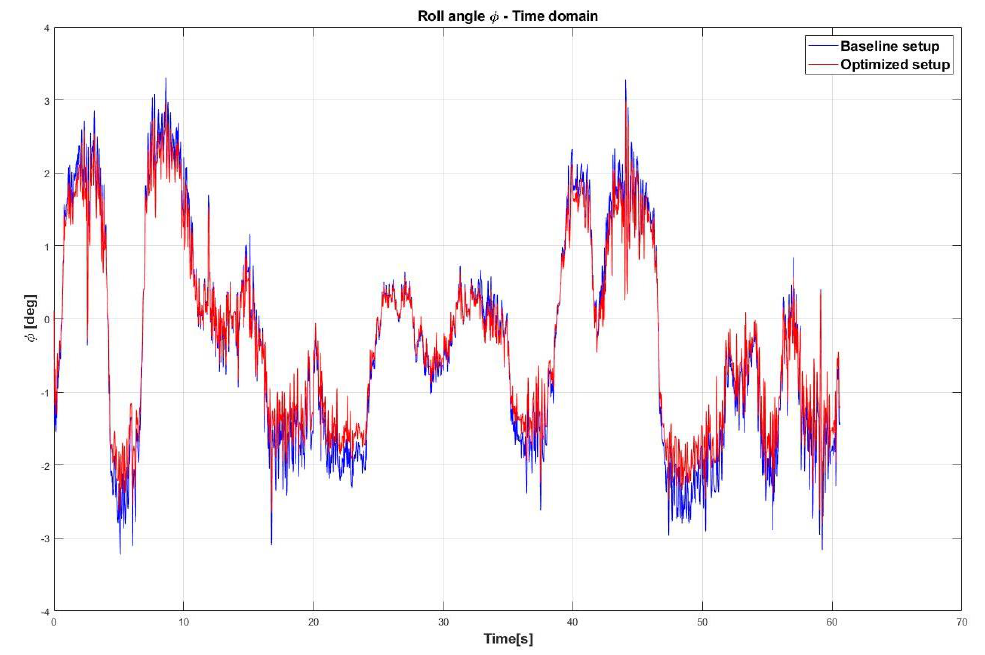
Figure 20. Comparison between the baseline provided setup and improved setup for the roll angle trend in the time